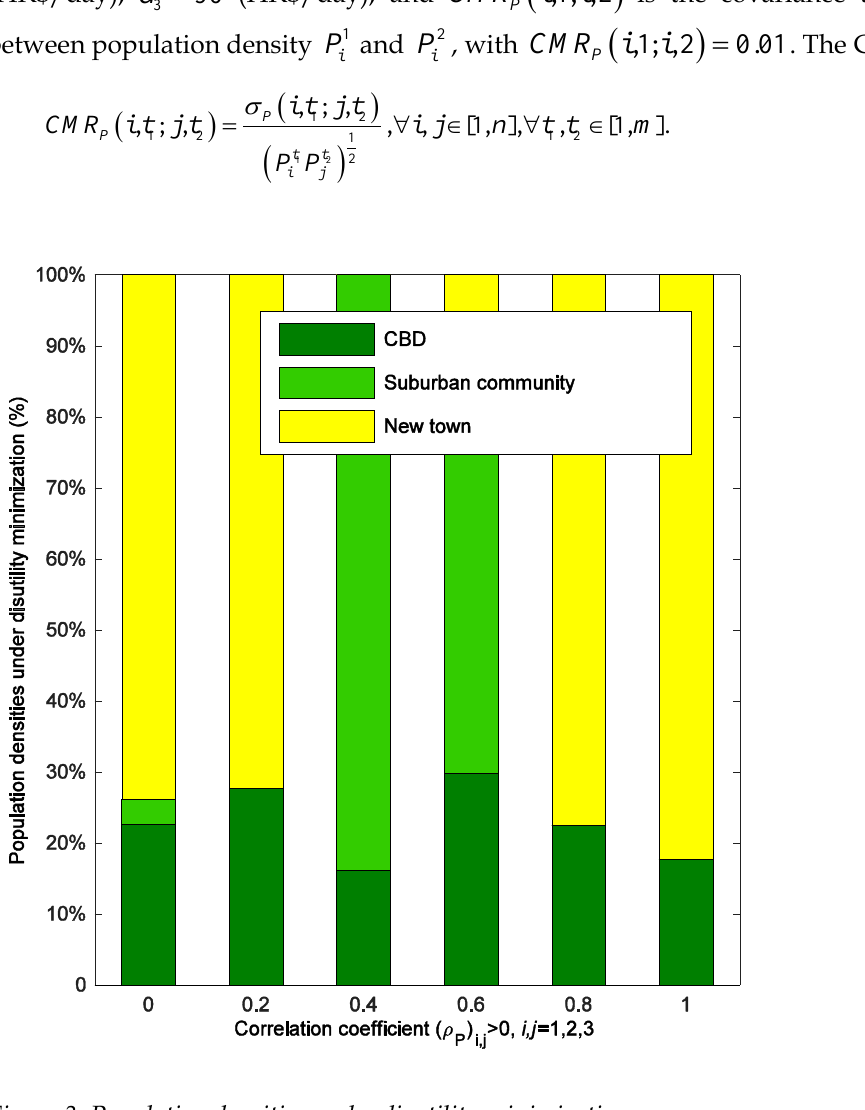
Figure 3. Population densities under disutility minimization